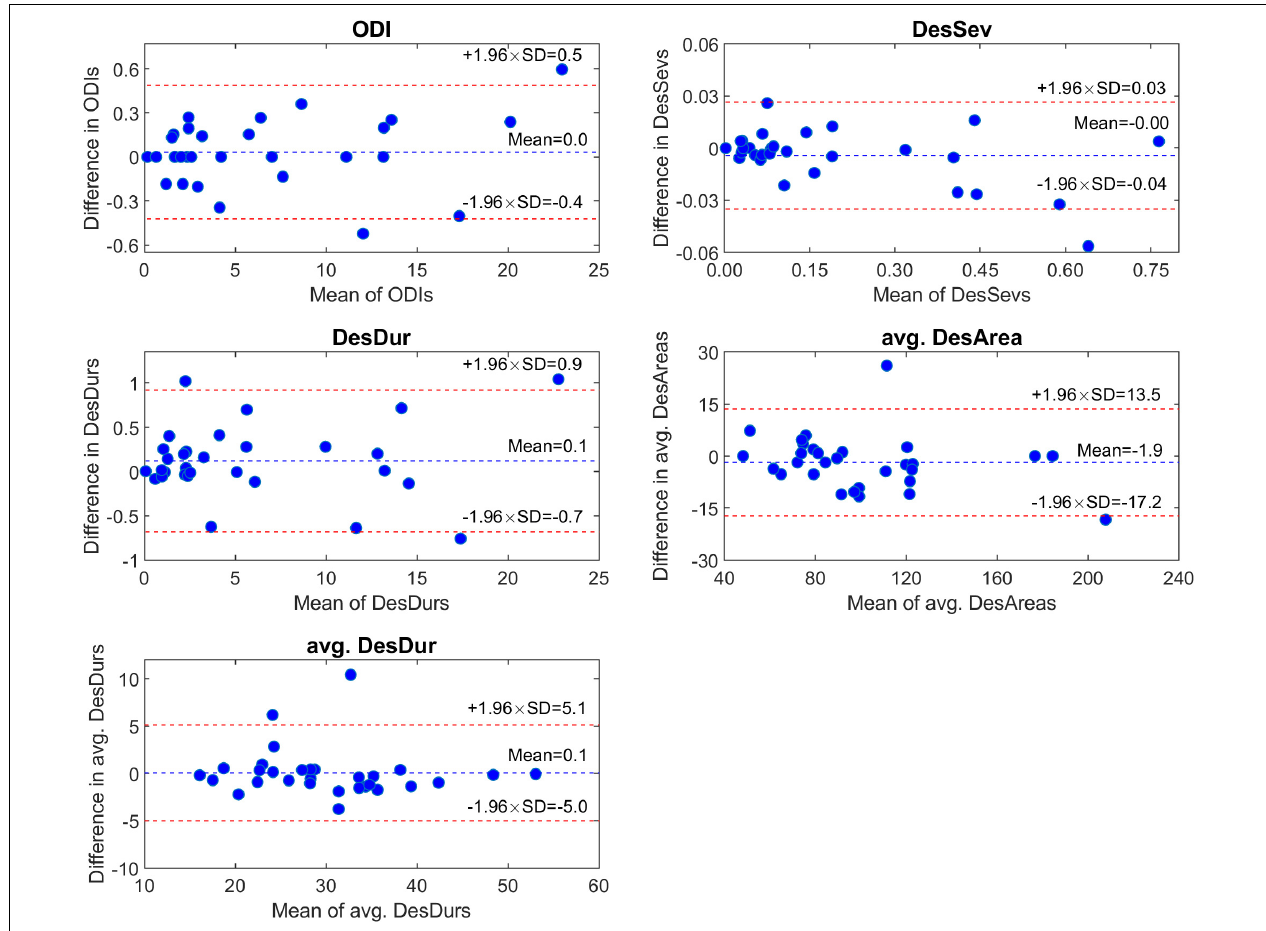
FIGURE 1 | Comparison of automatically and manually scored desaturation parameter values of 30 randomly selected oxygen saturation signals using Bland-Altman plots. ODI, oxygen desaturation index; DesSev, desaturation severity parameter; DesDur, desaturation duration parameter; avg. DesArea, average area of individual desaturation events; avg. DesDur, average duration of individual desaturation